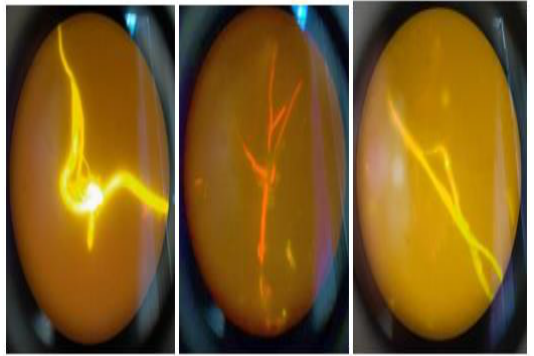
Figure 2. Detection of fungal elements using calcofluor white stain.